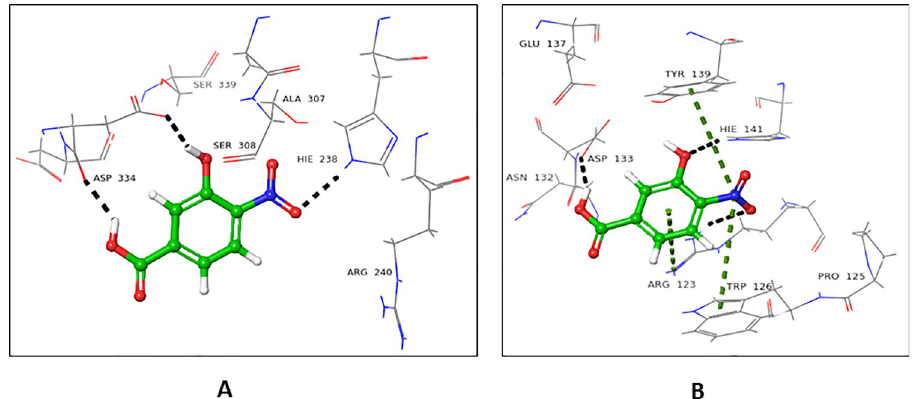
Fig 11. Interactions of compound 27 with the (A) donor and (B) acceptor domain of FUT2. 3D Ligand interactions diagram; black dashed lines representing hydrogen bonding bond.